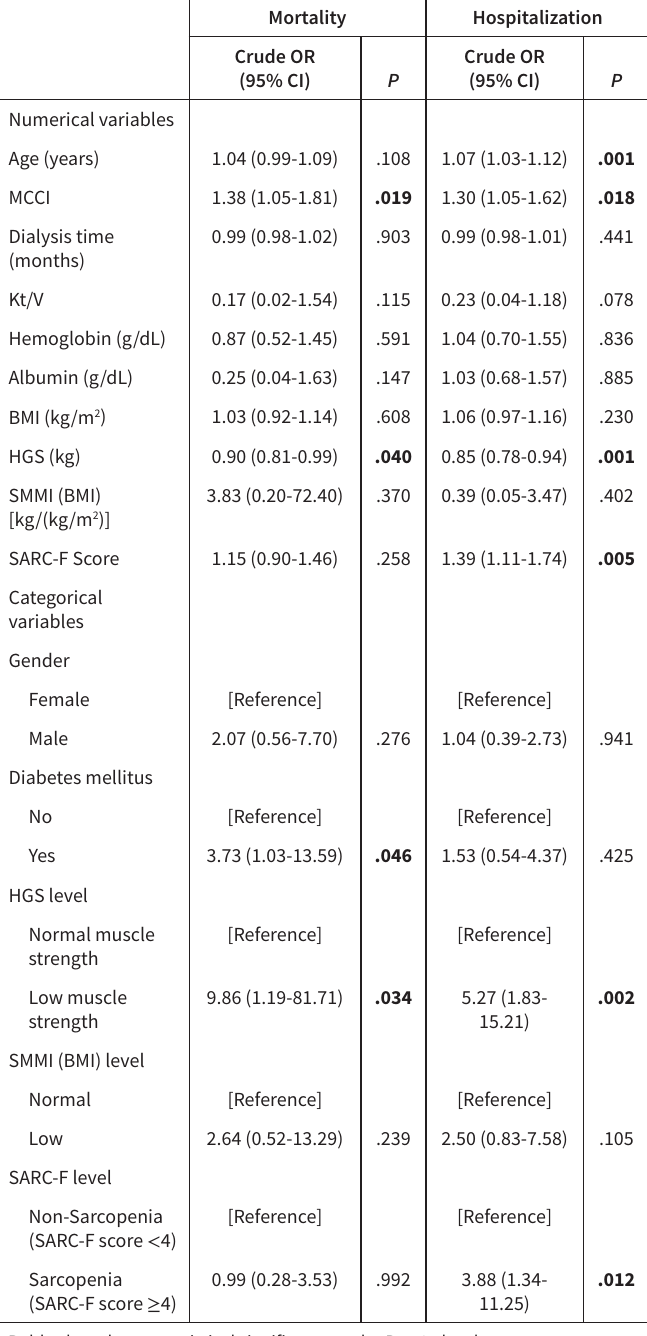
patients with a SARC-F value of ≥ 4 had a 3.88 times higher risk Table 2. Evaluation of Risk Factors for Mortality and of hospitalization compared to those with a SARC-F value of < 4 Hospitalization in Hemodialysis Patients by Univariate Logistic (OR = 3.882, 95% CI = 1.340-11.252, P =.012). However, the effect Regression Analysis of SARC-F on hospitalization was not statistically significant Mortality Hospitalization